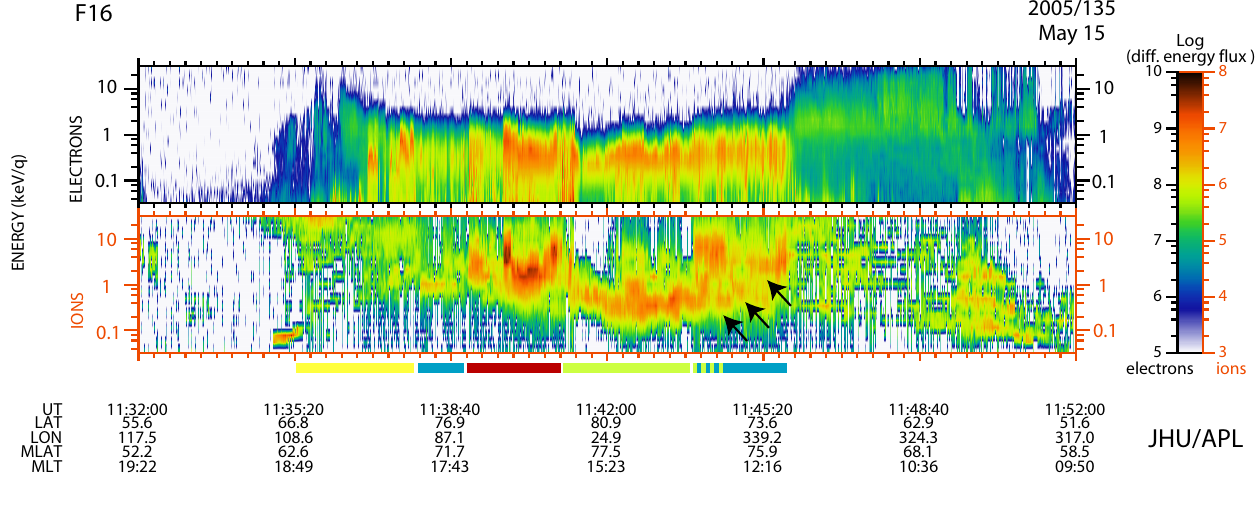
Fig. 7. Energy-time spectrograms of electrons and ions obtained by the DMSP F16 satellite from 11:32 to 11:52UT. The scales are logarithmic for ordinate and colour (differential energy flux). The colour bars at the bottom correspond to precipitation regions shown in Fig. 9. Figure 7 is the precipitating particle data observed by F16 during the northward IMF period. The energy-time spectro- grams for electrons (top) and ions (bottom) are